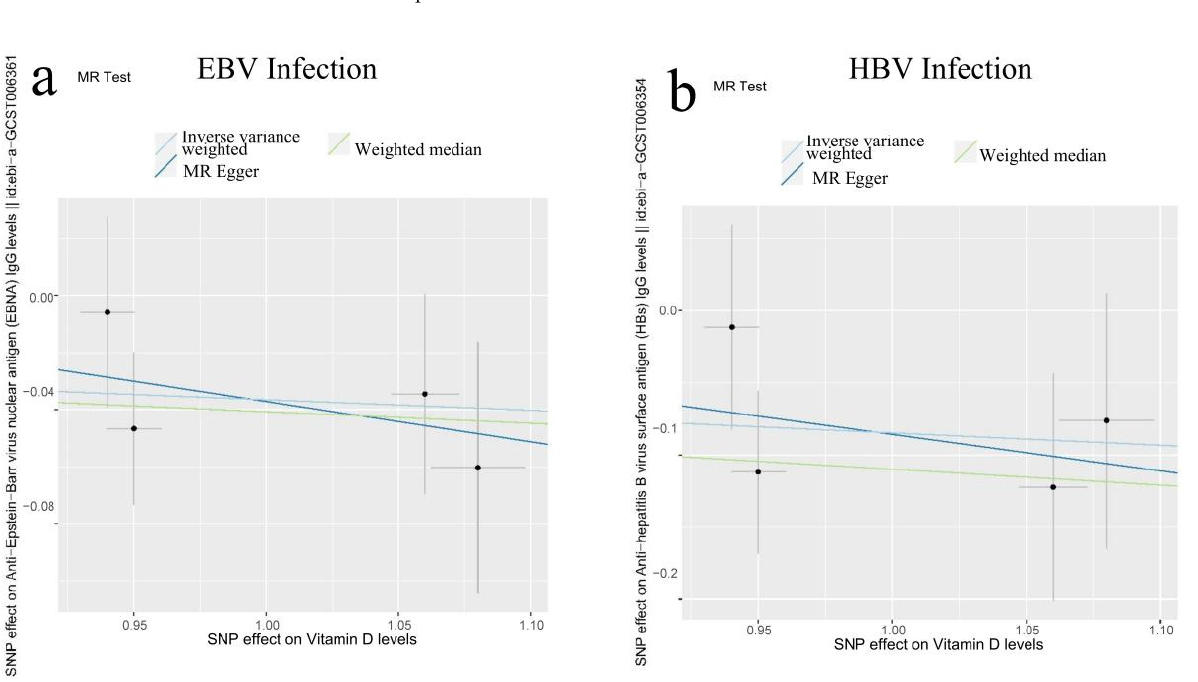
Figure 9. Results of Two sample Mendelian Randomization (2SMR) between vitamin D levels and indicator levels of viral infections. A causal relationship between vitamin D levels and indicator levels of EBV infection ( a ) and indicator levels of HBV infection ( b ) was calculated using the 2SMR method. We used three methods provided by the R package “TwoSampleMR”, MR Egger, Inverse variance Weighted (IVW) and Weighted Median (WM) to calculate the causal relationship between various nutrients and disease. ( a ) Results calculated by the three methods showed a negative correlation between vitamin D and indicator levels of EBV infection, suggesting that vitamin D supplementation may reduce the risk of EBV infection. ( b ) Results calculated by the three methods showed a negative correlation between vitamin D and indicator levels of HBV infection, suggesting that vitamin D supplementation may reduce the risk of HBV infection. Table 2. 2SMR results for nutrients and indicator levels of viral infections.